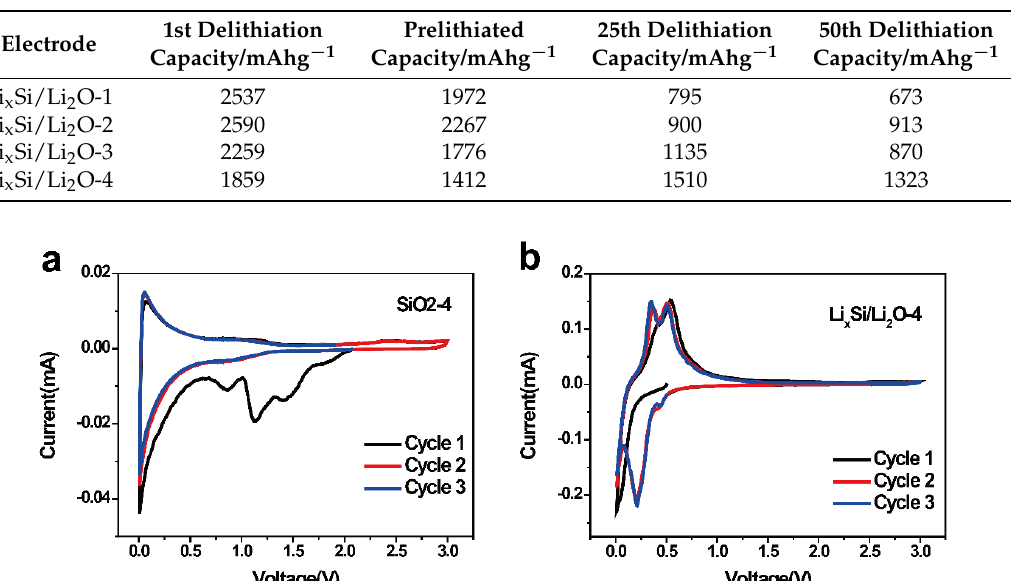
Figure 4. Cycling voltammetry measurement of SiO 2 electrodes before ( a ) and after ( b ) prelithiation. Table 1. Cycling performance for Li x Si/Li 2 O electrodes.